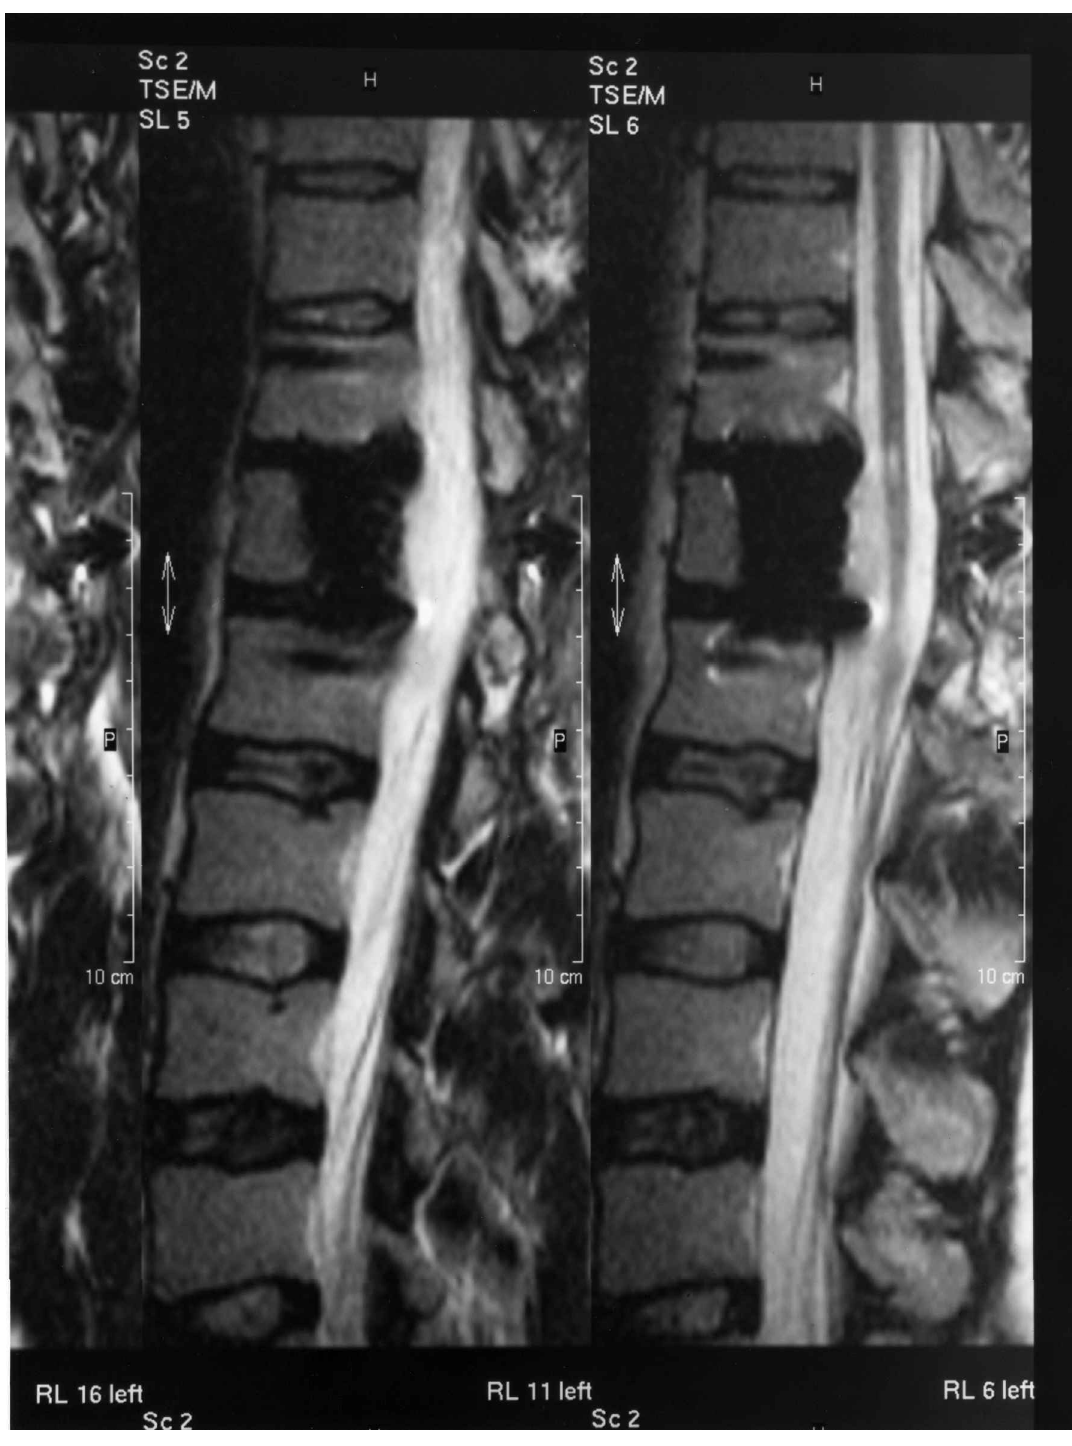
Fig. 4. Saggittal T2W showing decompression of the theca